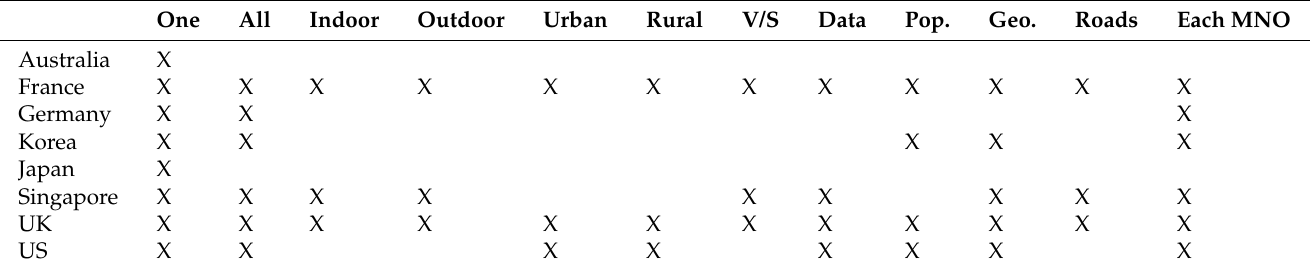
Table 5. Broadband coverage report.